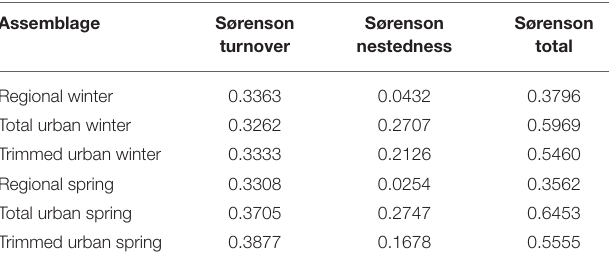
TABLE 4 | Multi-site Sørensen dissimilarities between the regional species pools, total urban species assemblages, and trimmed urban species assemblages in each